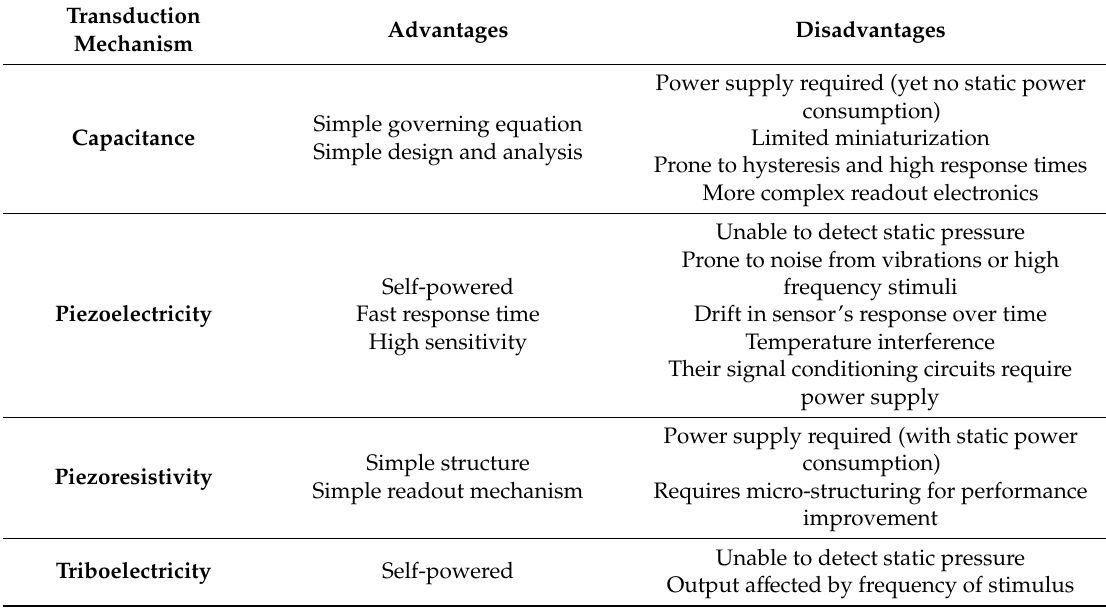
Table 2. Comparison between the most used transduction mechanisms in pressure sensors